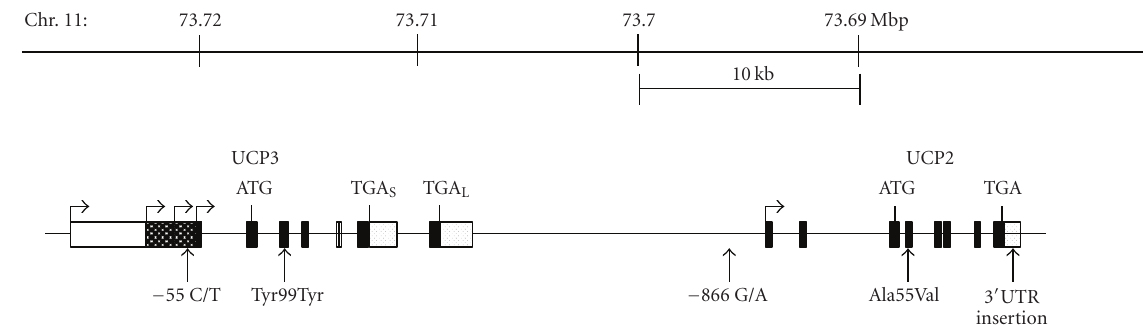
Figure 2: Diagram of the UCP2-UCP3 genomic region with indications of common genetic variation. Genomic organization of the UCP2- UCP3 region on chromosome 11. ATG: start codon, TGA: stop codon. Bent arrows indicate reported transcription start sites (from [34]). UCP3 protein exists in a short and a long form due to alternative polyadenylation sites, indicated by TGA S and TGA L